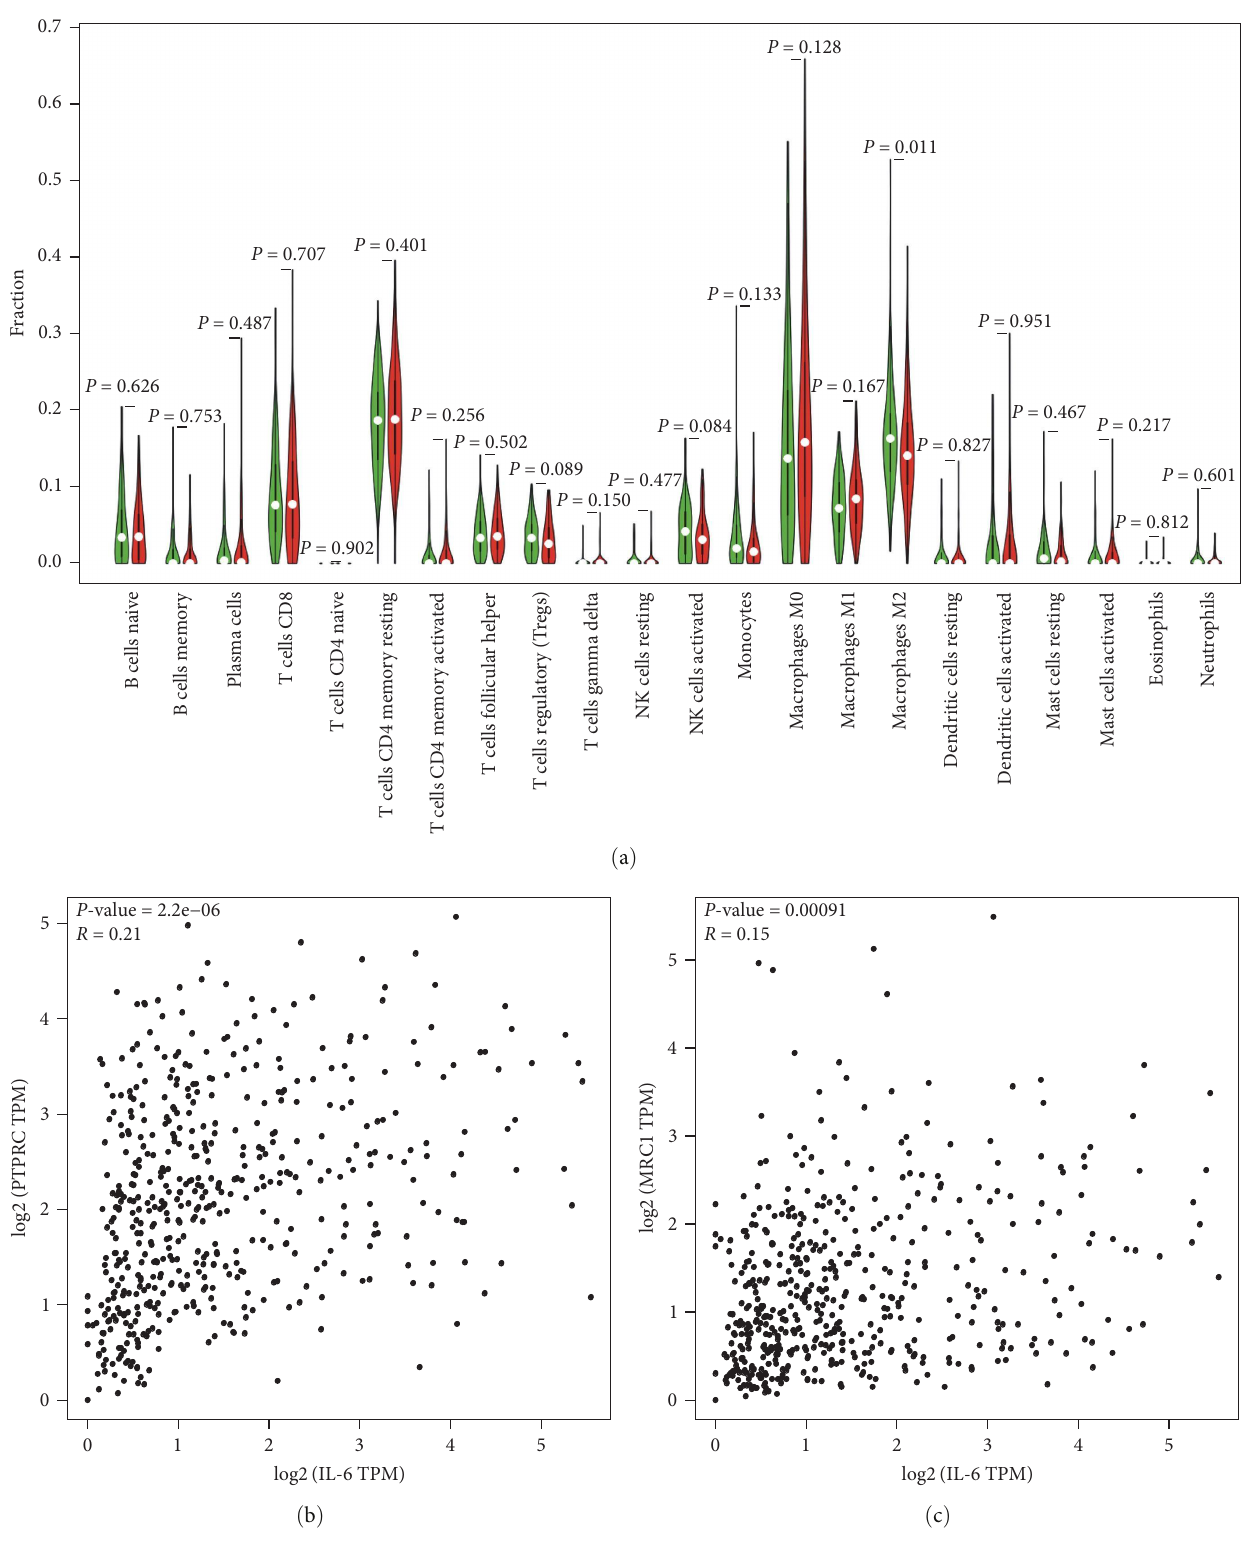
F IGURE 5: The correlation between IL-6 and macrophage. (a) Difference in distribution of immune cells between high- and low- expression groups of IL-6. Red: high-expression group; Green: low-expression group. (b) and (c) The positive correlation between IL-6 and macrophages and M2. CD45/PTPRC is widely recognized as a surface marker for macrophages, and CD206/MRC1 is widely recognized as a surface marker for